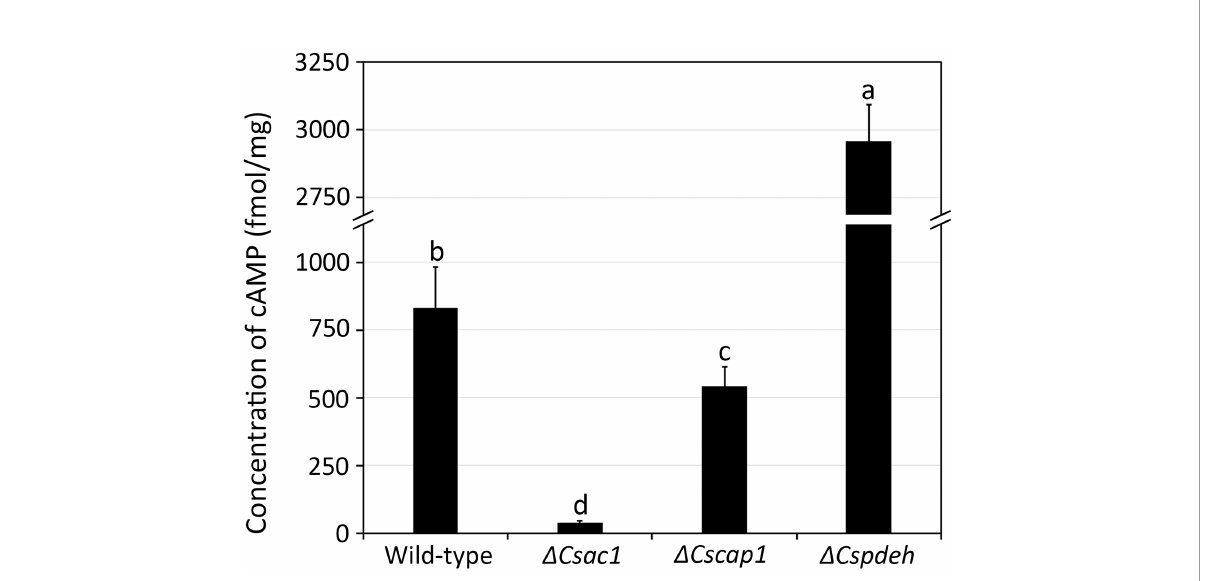
FIGURE 2 Quantitative measurement of intracellular cAMP concentration. Wild-type, D Csac1 , D Cscap1 , and D Cspdeh were inoculated into 50 mL of CM broth and rotated at 150 rpm and 25°C for 3 days. The intracellular cAMP level was measured using 100 mg of mycelial powder. Error bars show standard deviations and different letters in the same group indicate signi fi cant differences estimated using Duncan ’ s test (P <